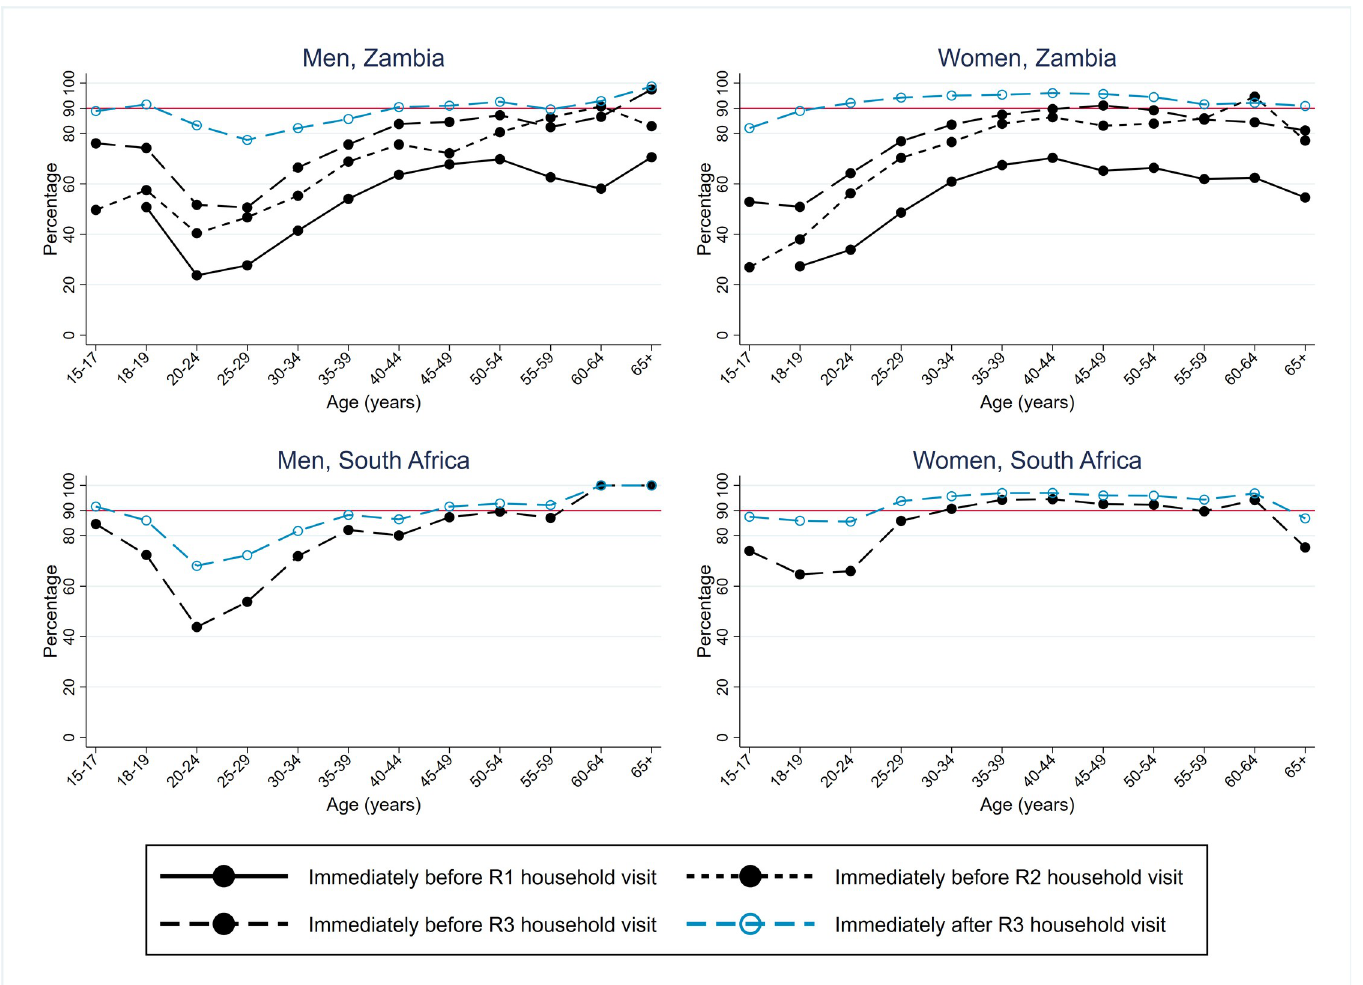
Fig 6. Arm A: Estimates of coverage against the first 90 target, Zambian communities R1–R3, and SA communities R3, by sex and age group (with extrapolation to the total population). R1, Round 1; R2, Round 2; R3, Round 3; SA, South Africa.